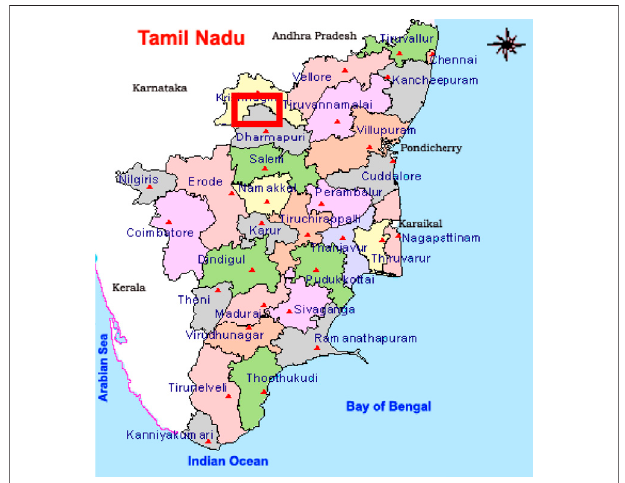
FIGURE 1 | Location of the Vanniyar basin, Dharmapuri district, Tamil Nadu, India. Sources: Maps of India.